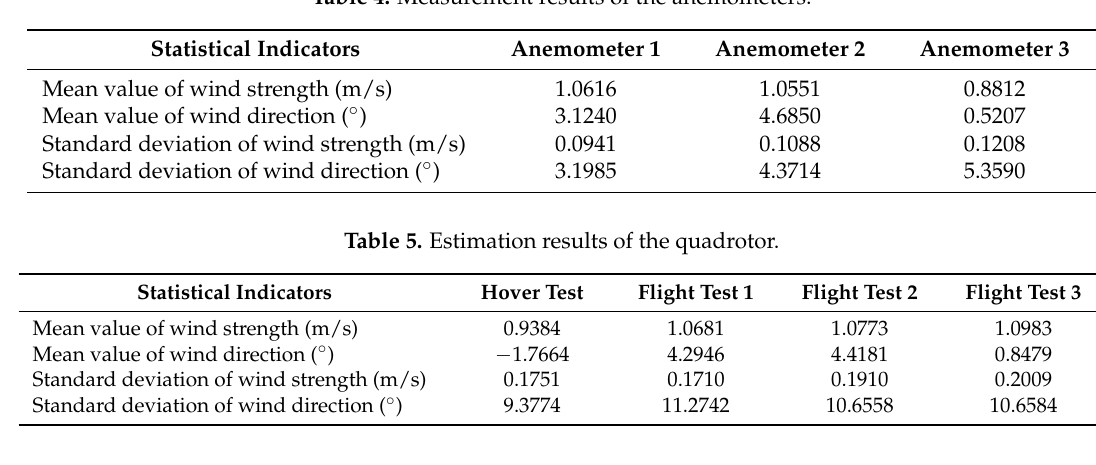
Figure 14. Measurement results by three 3D anemometers. ( a – c ) are the measurement results by Anemometers 1, 2 and 3, respectively. Table 4. Measurement results of the anemometers.